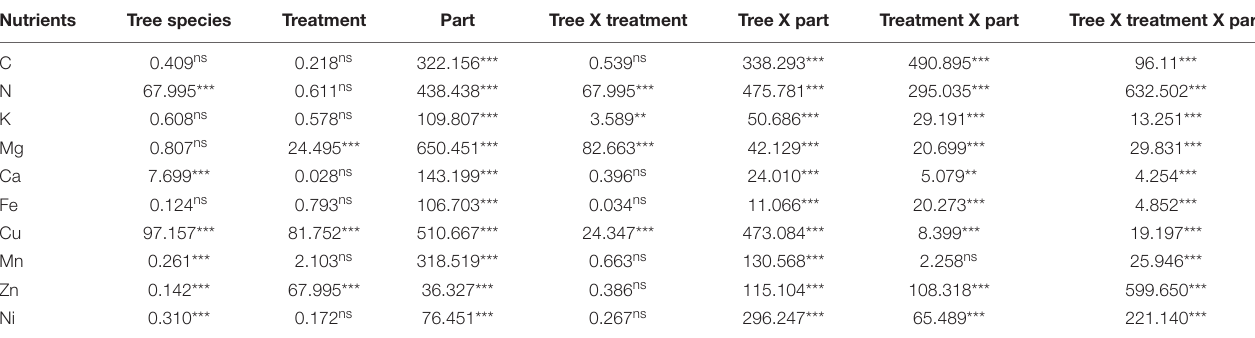
TABLE 4 | F-ratios and level of significance of three-way ANOVA test for various nutrients of the test tree species. Nutrients Tree